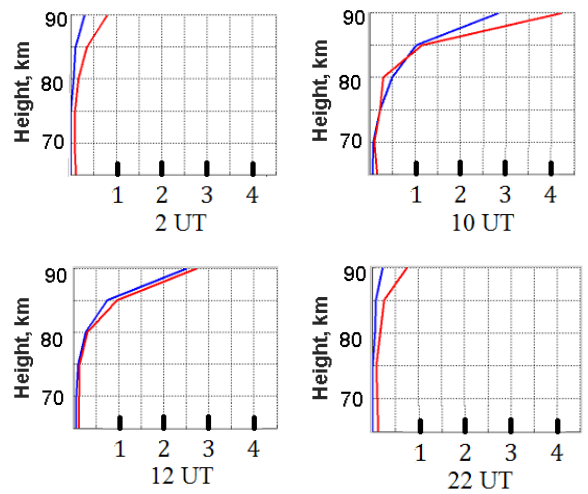
Fig. 7. Electron density (lg[ N e ], cm -3 ).